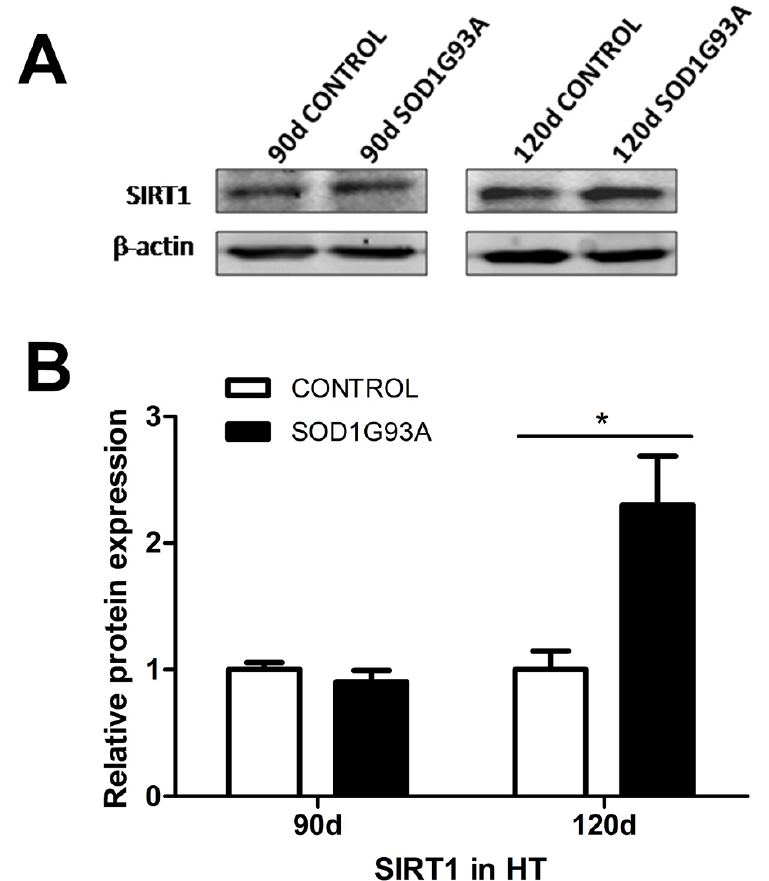
Figure 1. SIRT1 levels are increased in symptomatic SOD1G93A transgenic mice. ( A ) Protein ex- pression levels of SIRT1 in the hypothalamus between SOD1G93A mice and control mice at 90 days and 120 days, as evaluated by western blotting. ( B ) Statistical results of SIRT1 expression between SOD1G93A mice and control mice at 90 days and 120 days. The data are expressed as the mean ± standard error ( n = 4–6/group). * p < 0.05. HT,